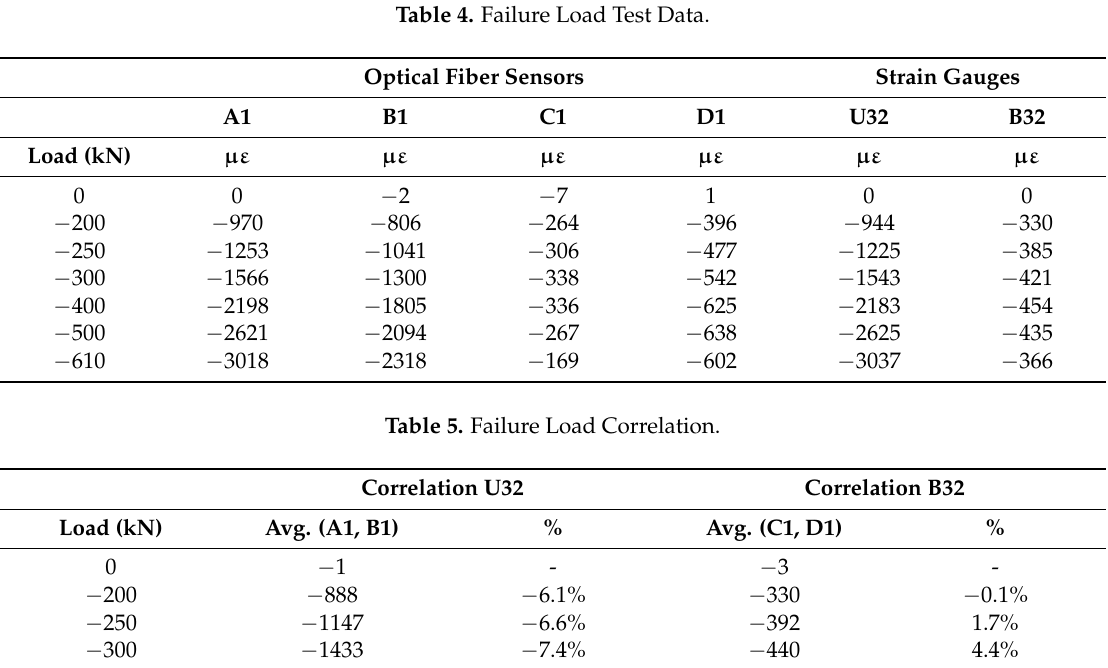
Table 5. Failure Load Correlation.